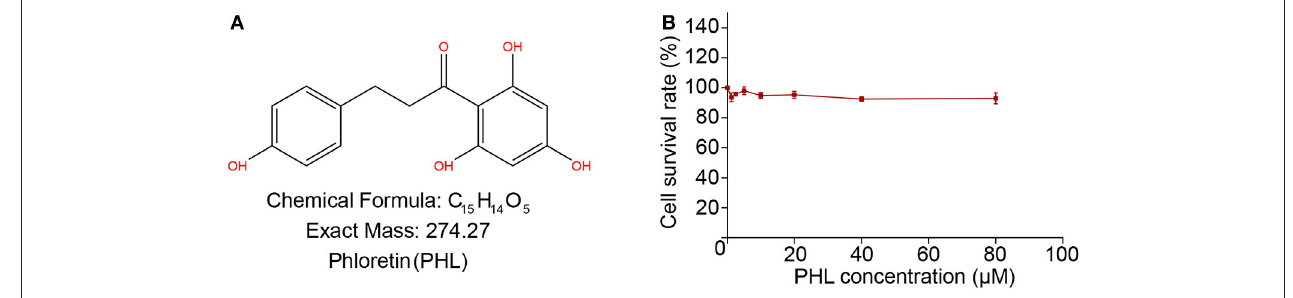
FIGURE 1 | The chemical structure of Phloretin (A) . MTT assay tests the effect of PHL on H9c2 survival rate after 24h treatment (B) .